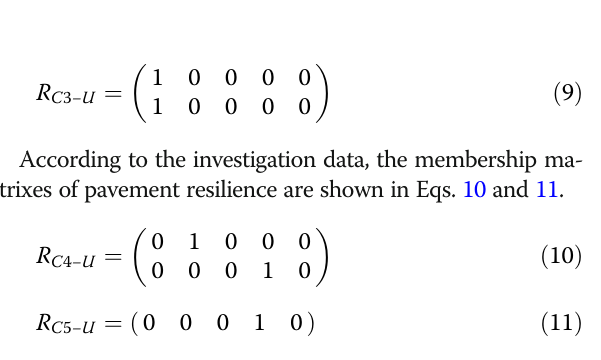
Pavement Exposure Pavement Fragility Pavement Resilience